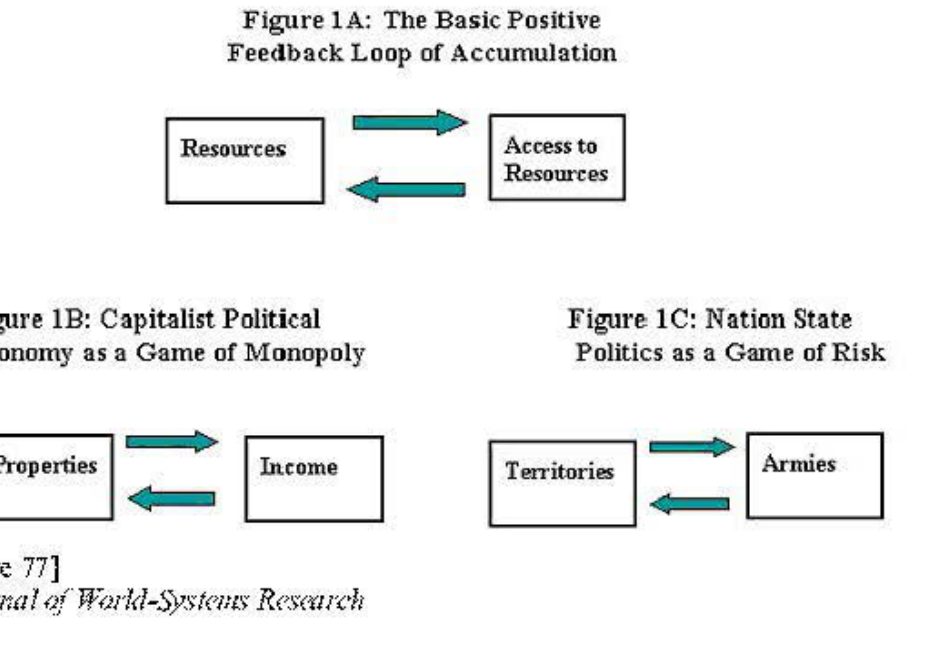
Figure 1: Basic Struciures of Accwnulation Figure lA: The Basic Positive Fee<lback Loop of Accumulation